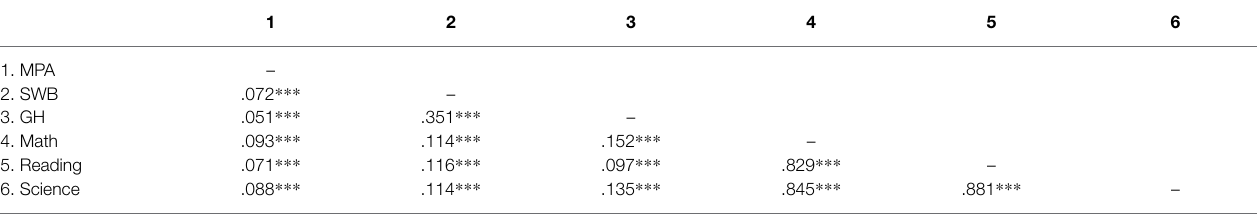
TABLE 4 | Correlation matrix of SEM input measures ( N = 63,228).